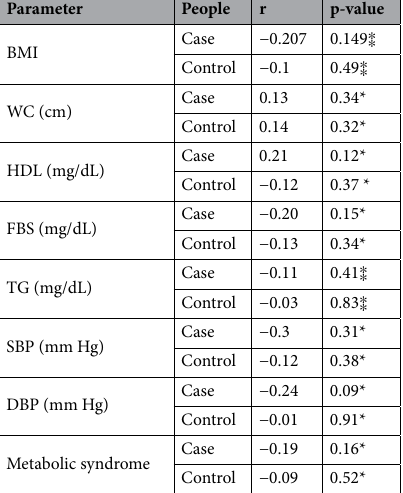
Table 4. Correlation of the serum NO level with metabolic syndrome components in the case and control groups. *Pearson Correlation. *Spearman